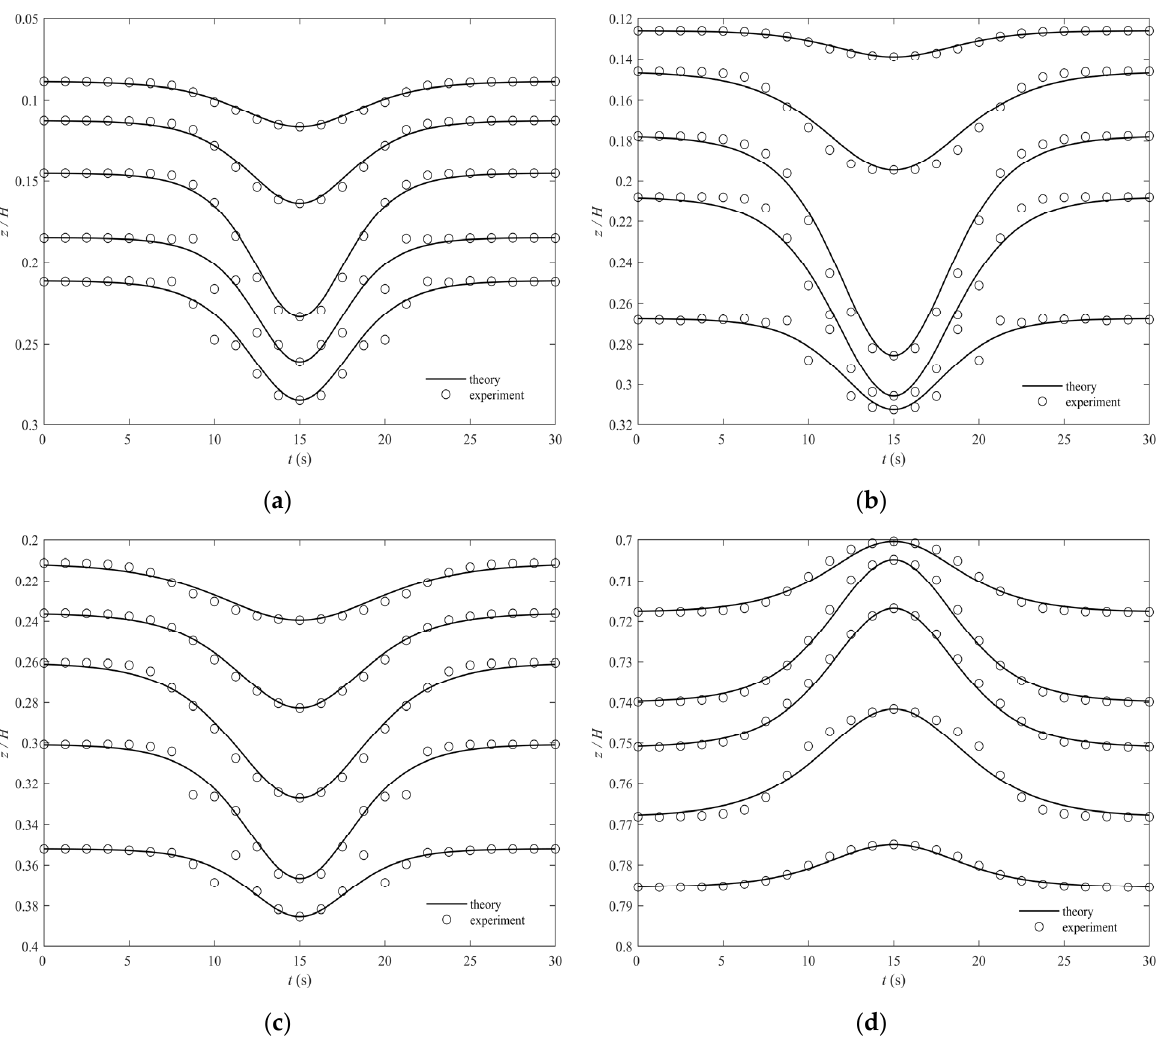
Figure 9. Experimental and theoretical waveforms of ISWs at different depths: ( a ) S1; ( b ) S2; ( c ) S3; ( d )